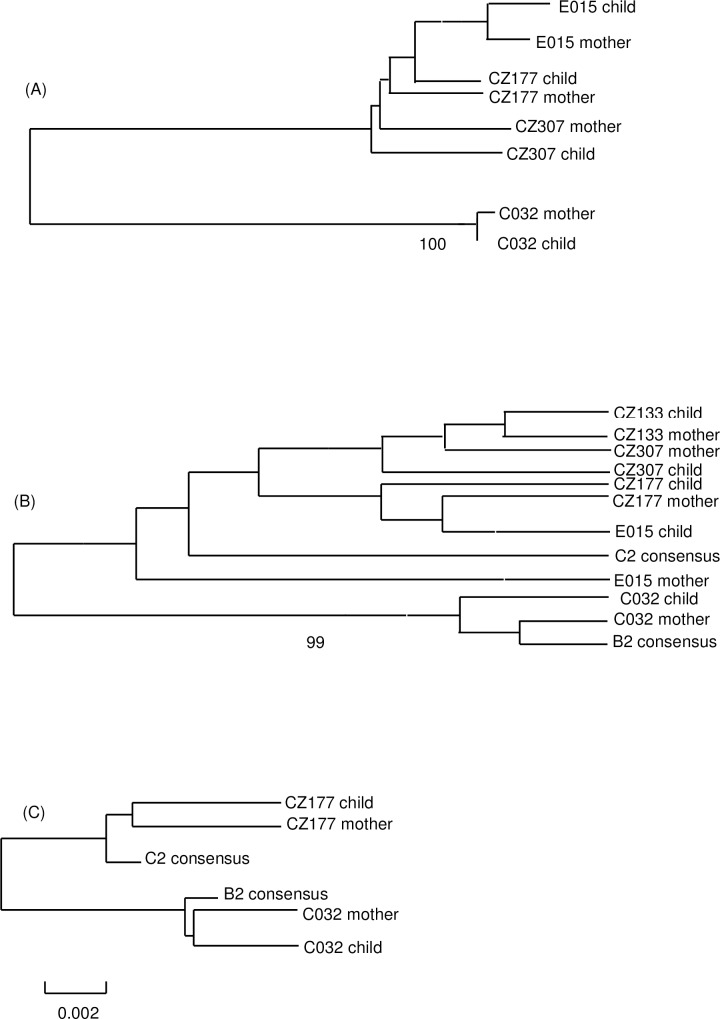
Phylogenetic trees of mother-child HBV pairs.(A) phylogenetic tree of RT region; (B) phylogenetic tree of Pre-S region; (C) phylogenetic tree of Core region.